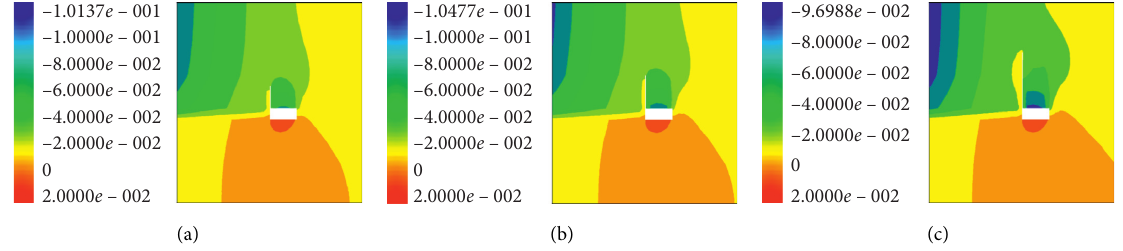
Figure 9: Vertical displacement diagram of different roof cutting height. (a) 4m. (b) 6m. (c)